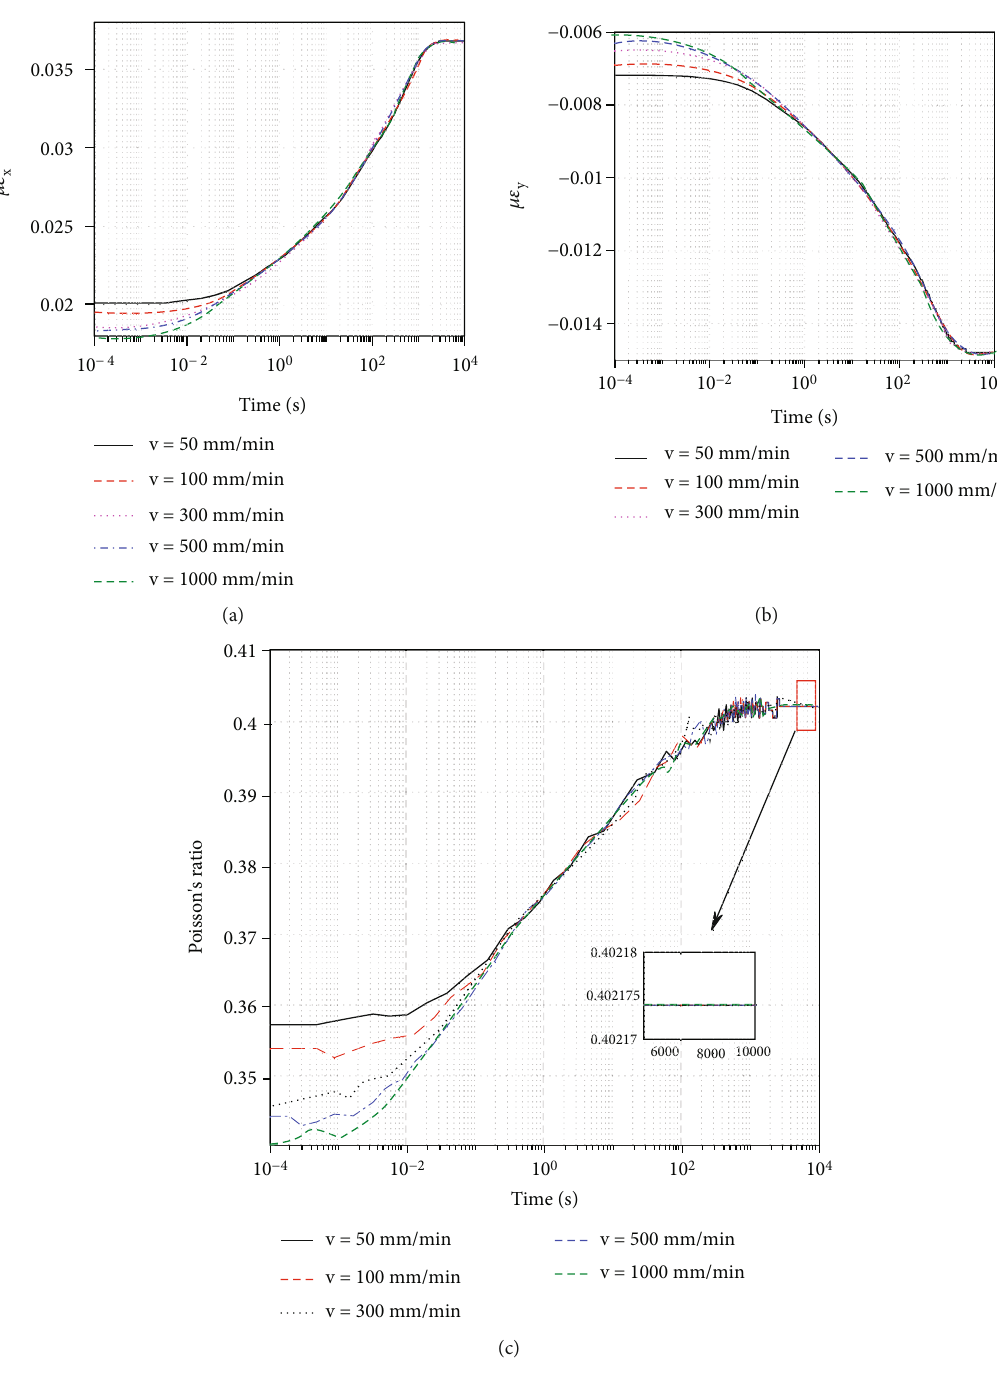
Figure 14: The curves of the (a) longitudinal strain, (b) transverse strain, and (c) Poisson ’ s ratio versus time under di ff erent loading rates when cohesive strength equals to